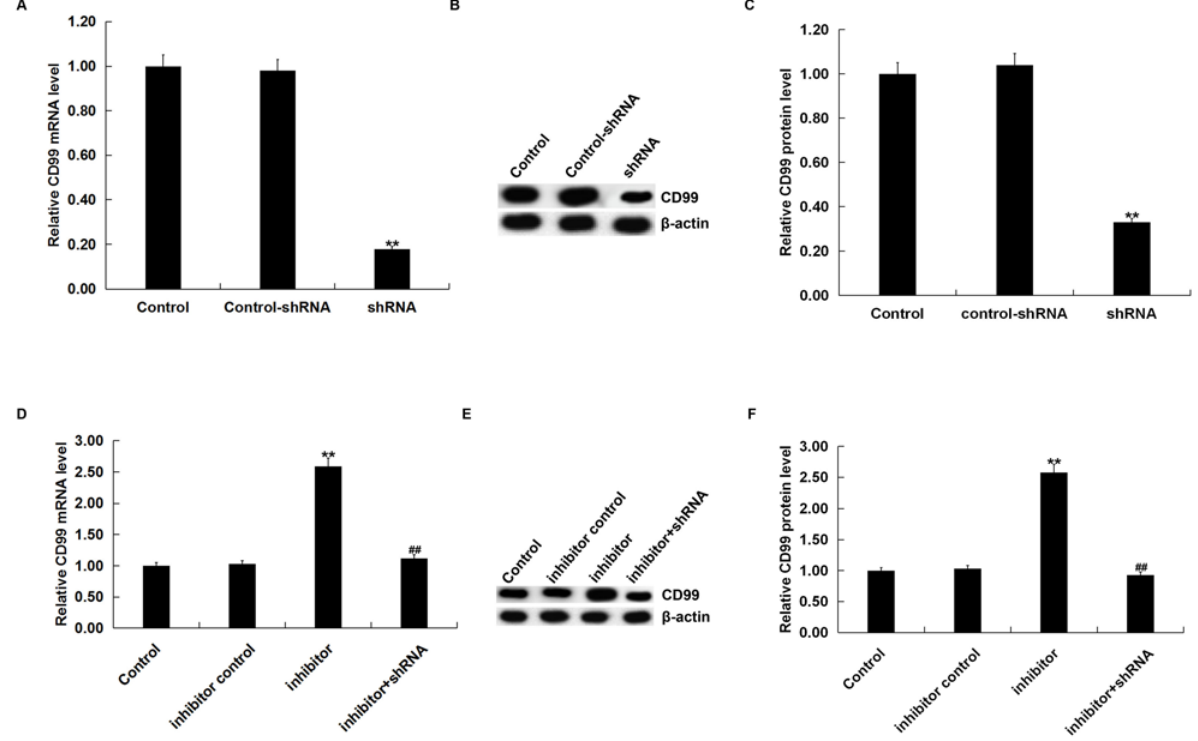
Figure 4: The expression level of miR-663b and CD99 in Jurkat cells after transfection. qRT-PCR assay (A) and western blot assay (B and C) detected the mRNA and protein expression CD99 of in Jurkat cells that were transfected with control-shRNA or CD99-shRNA. qRT-PCR (D) and western blot assay (E and F) detected the mRNA and protein expression of CD99 in Jurkat cells that were transfected with inhibitor control, miR-663b inhibitor or miR-663b inhibitor+CD99-shRNA for 48 h. The data were expressed as the mean ± SD. **p<00.01 vs. Control; ##p<00.01 vs.